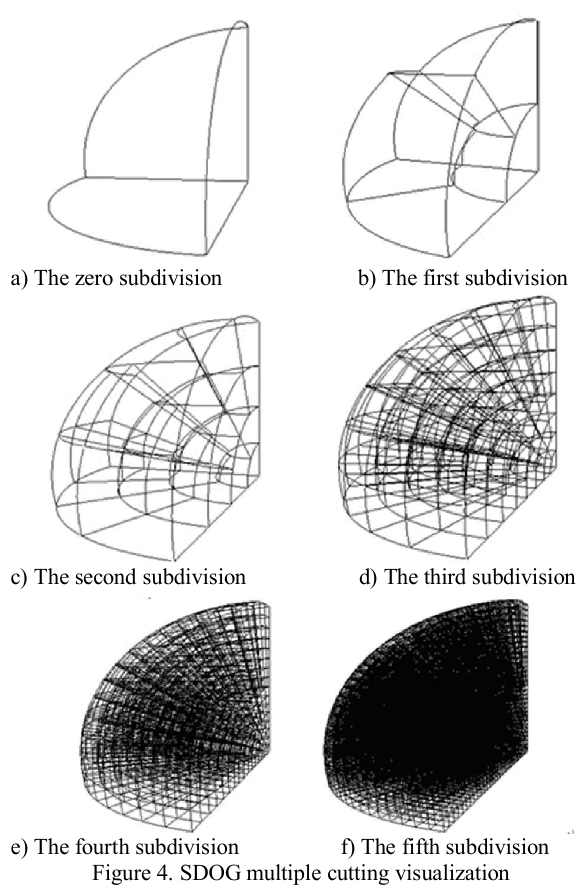
Figure 4. SDOG multiple cutting visualization